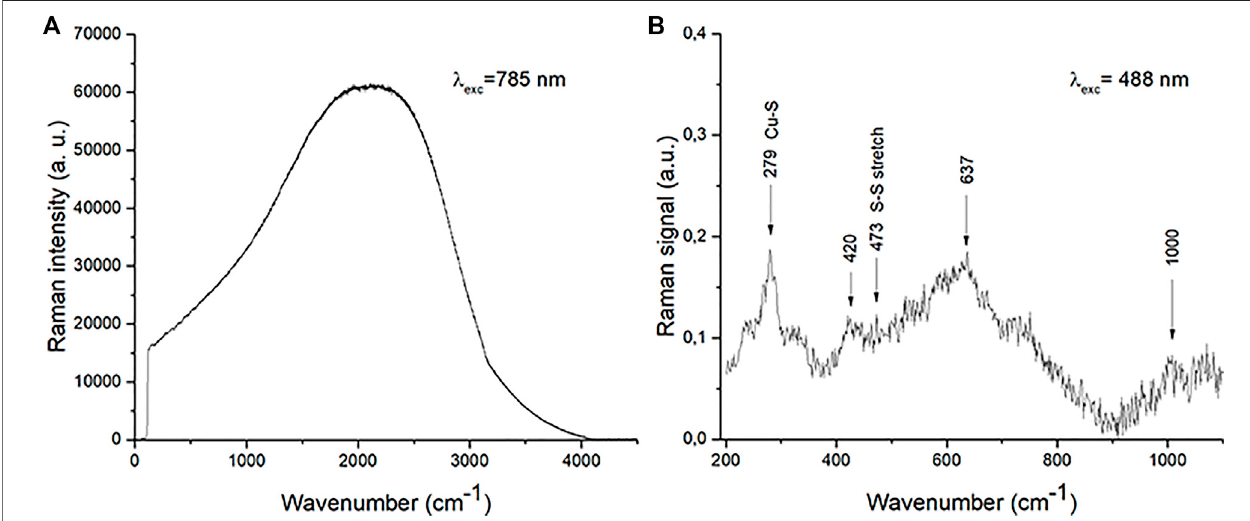
FIGURE 11 | Raman spectra of the washed CuS-BSA sample (A) excited under 785 nm wavelength and (B) excited under 488 nm wavelength with background subtraction.